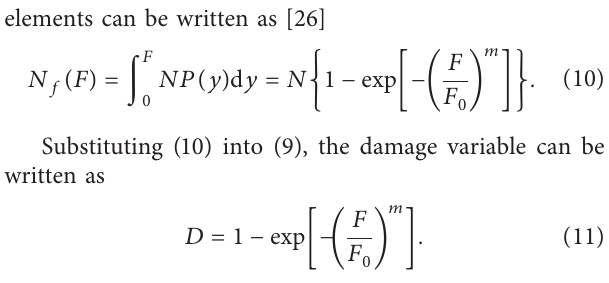
Figure 5: Schematic diagram of the deformation of each